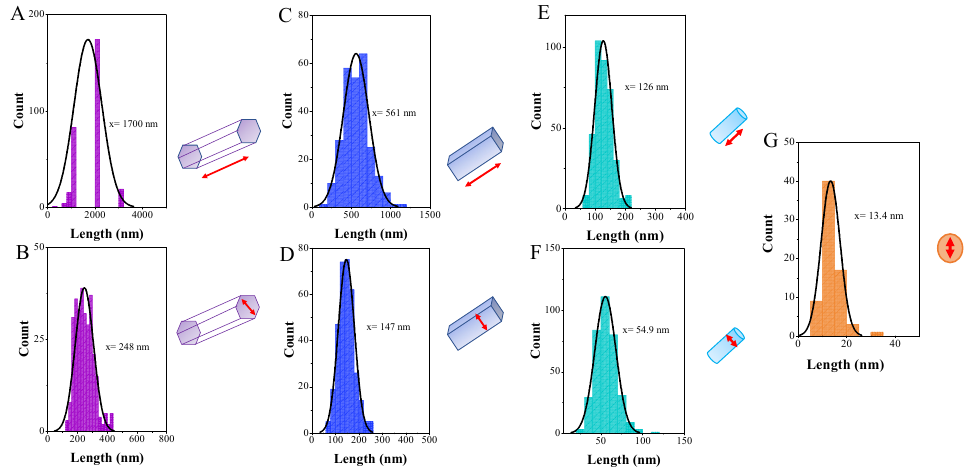
Figure 4. Average length and width distribution of α -Ag 2 WO 4 ( A , B ), α - Ag 2 WO 4 -TA ( C , D ), and α - Ag 2 WO 4 -BA ( E , F ) via FE-SEM. Average length and width distribution of α -Ag 2 WO 4 -CA ( G ) via TEM images.